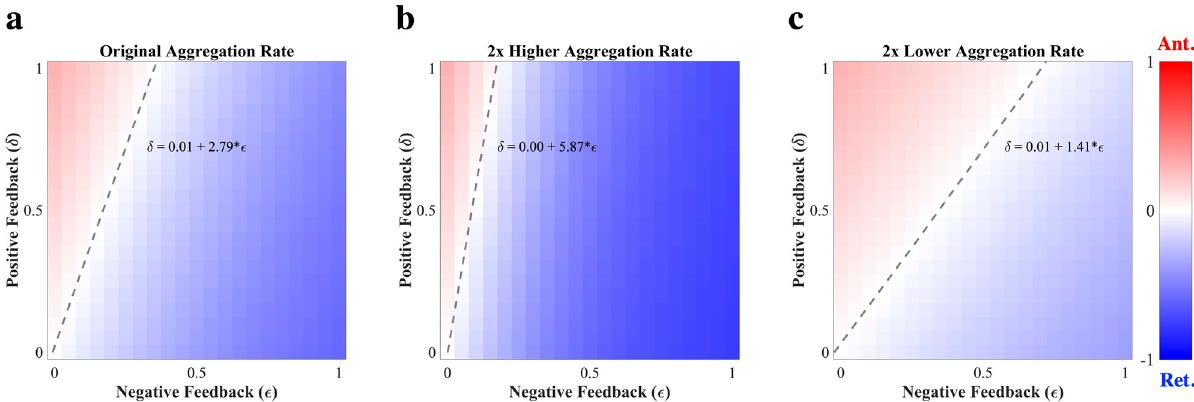
Fig 4. Steady-state bias analysis as a function of aggregation rate. (a) Steady-state bias (postsynaptic SD tau—presynaptic SD tau / total SD tau) across a range of δ and � parameter values where all other parameter values are identical to those of the previous simulations. There is a zero-bias linear manifold that emerges, whose best-fit line has a slope of approximately 2.8. (b) Steady-state bias for the same range of δ and � parameter values where aggregation rate ( γ ) is doubled. The linear zero-bias manifold has a slope of * 5.8, roughly twice that of the original aggregation rate. (c) Steady-state bias for the same range of δ and � parameter values where γ is halved. Here the slope of the linear manifold is * 1.4, or approximately half that of the original aggregation rate.